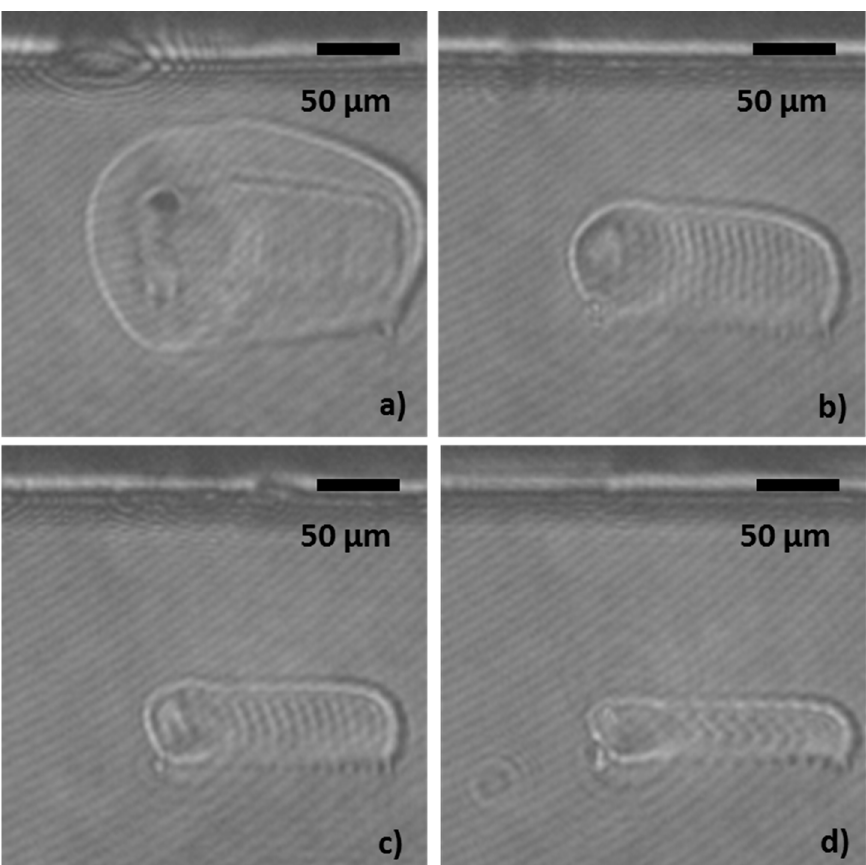
Figure 3. A sequence of images taken with the high speed camera showing variation of the striation period with the feed rate: ( a ) 2 mm/s; ( b ) 20 mm/s; ( c ) 50 mm/s; ( d ) 100 mm/s. The laser parameters remain constant: 450 kHz pulse repetition frequency and 3.3 W of average power. Please note appearance of the plasma collapse track in ( a ).